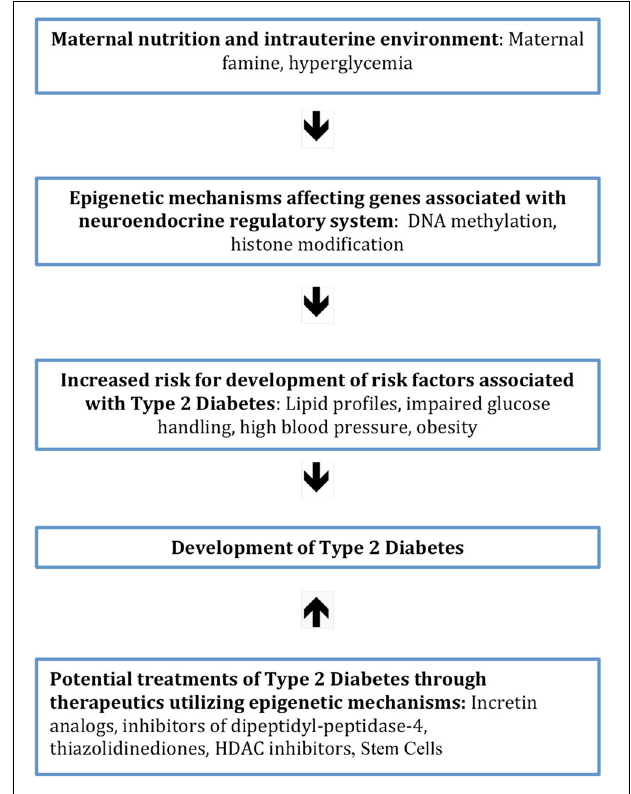
FIGURE 2 | Diagram showing the sequence of events between factors associated with the intrauterine environment and increased risk for the development of T2DM. This occurs through the initiation of epigenetic mechanisms that affect genes involving neuroendocrine regulation. Also illustrated is the potential treatment of T2DM with therapeutics that work through epigenetic